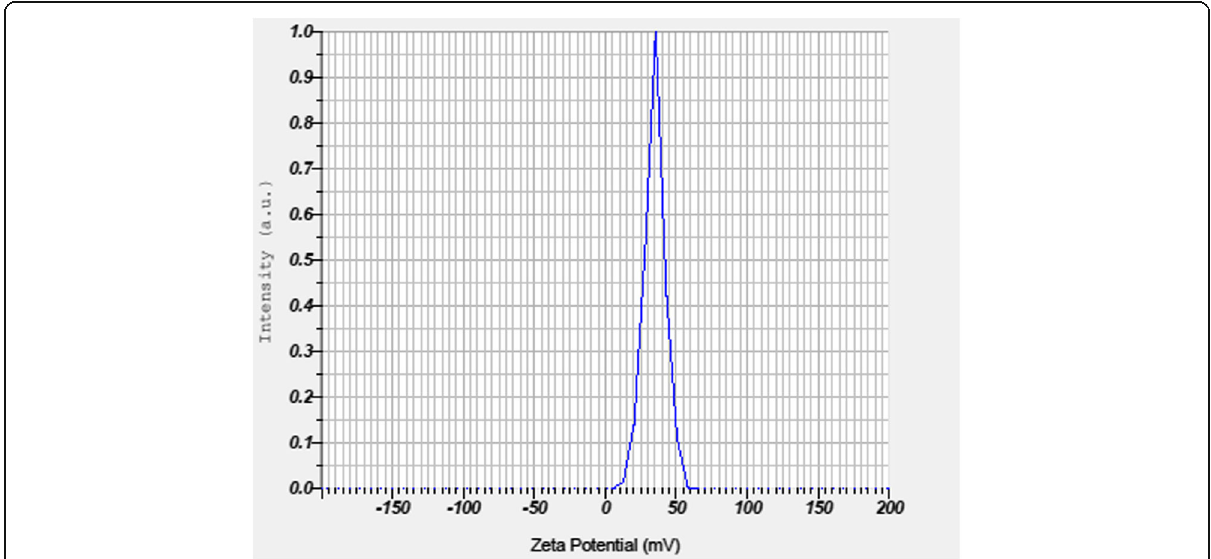
Fig. 5 Zeta potential analysis. CIL AuNPs — Zeta potential (mean): − 36.8 mV. CIF AuNPs — Zeta potential (mean): − 34.4